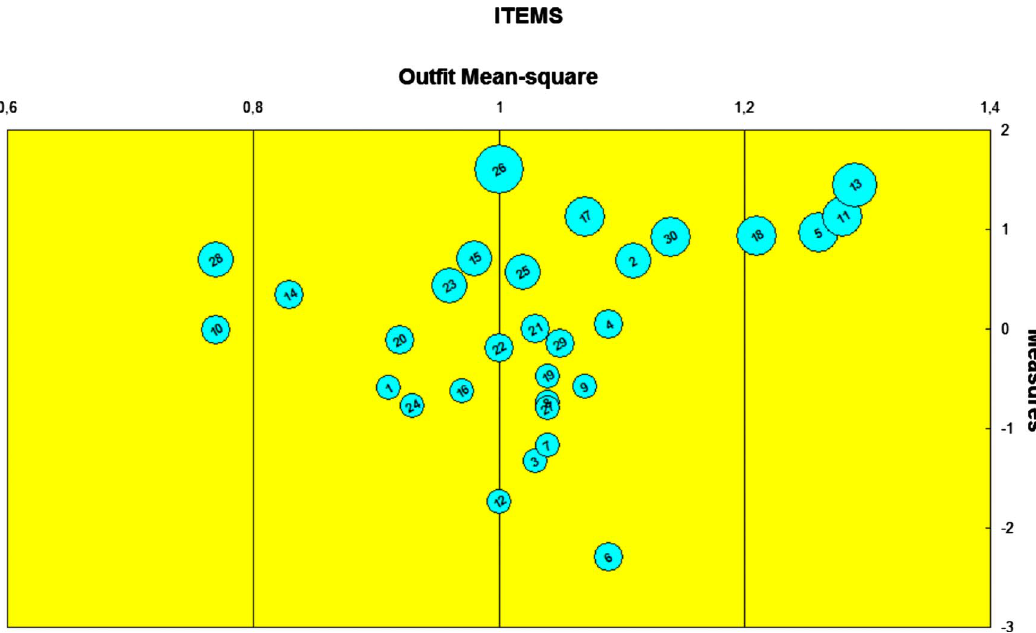
FIG. 4. (cid:1) Color (cid:2) The bubble chart for the gymnasium students showing outfit mean square statistics (cid:1) MNSQ (cid:2) vs item